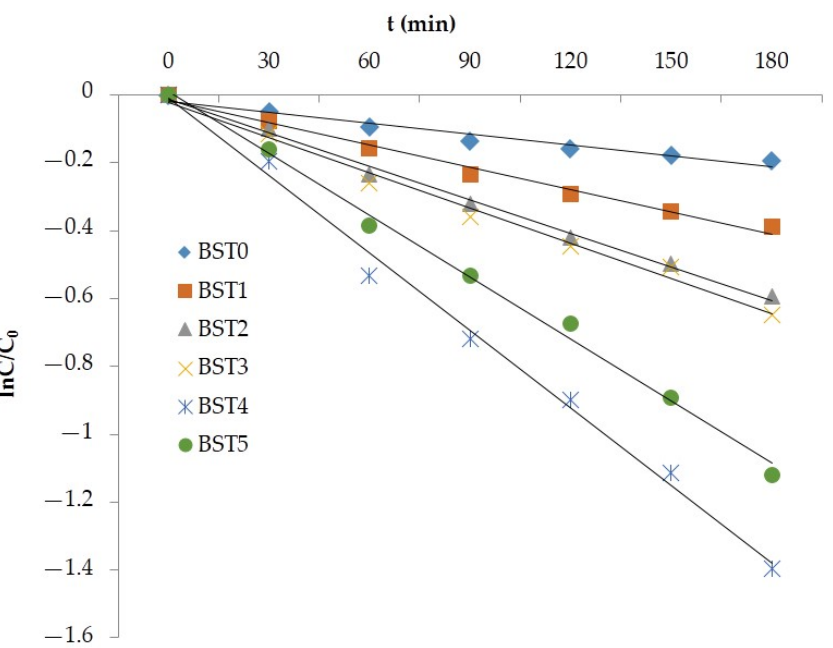
Figure 10. The reaction kinetics curves of degradation of RhB in different Bi-doped levels of wood samples.